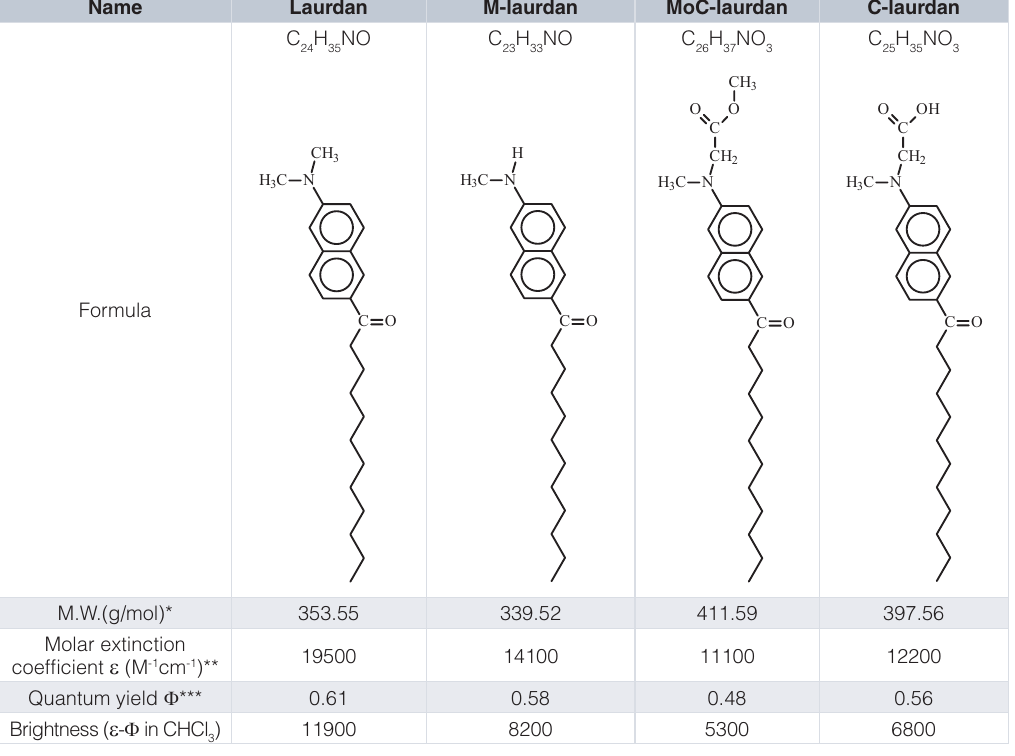
Table 1. Dyes formulae, molecular weight and basic photophysic characteristics measured in chloroform.